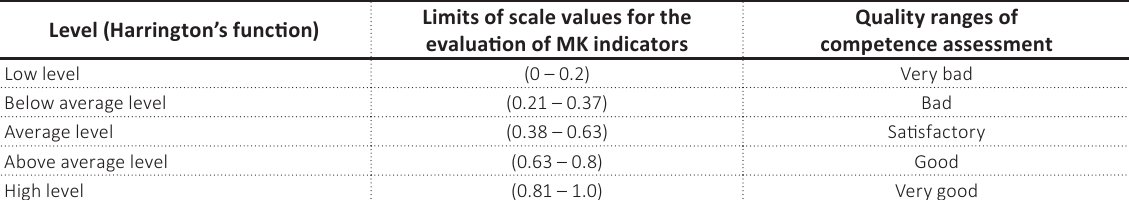
Table 6. Harrington